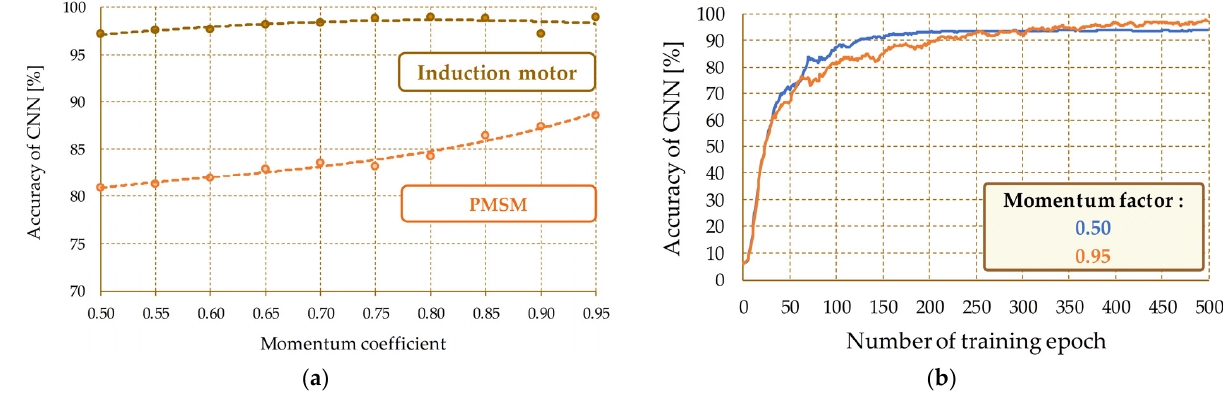
Figure 14. Impact of changes in the momentum factor on the precision of the diagnostic system: ( a ) precision of the response to the elements of the testing package; ( b ) learning curves, induction motor.